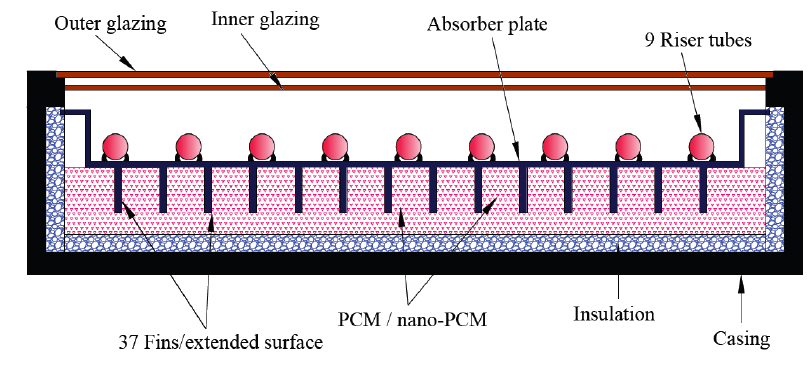
Fig. 6. Schematic view of the solar – thermal energy storage integrated collector